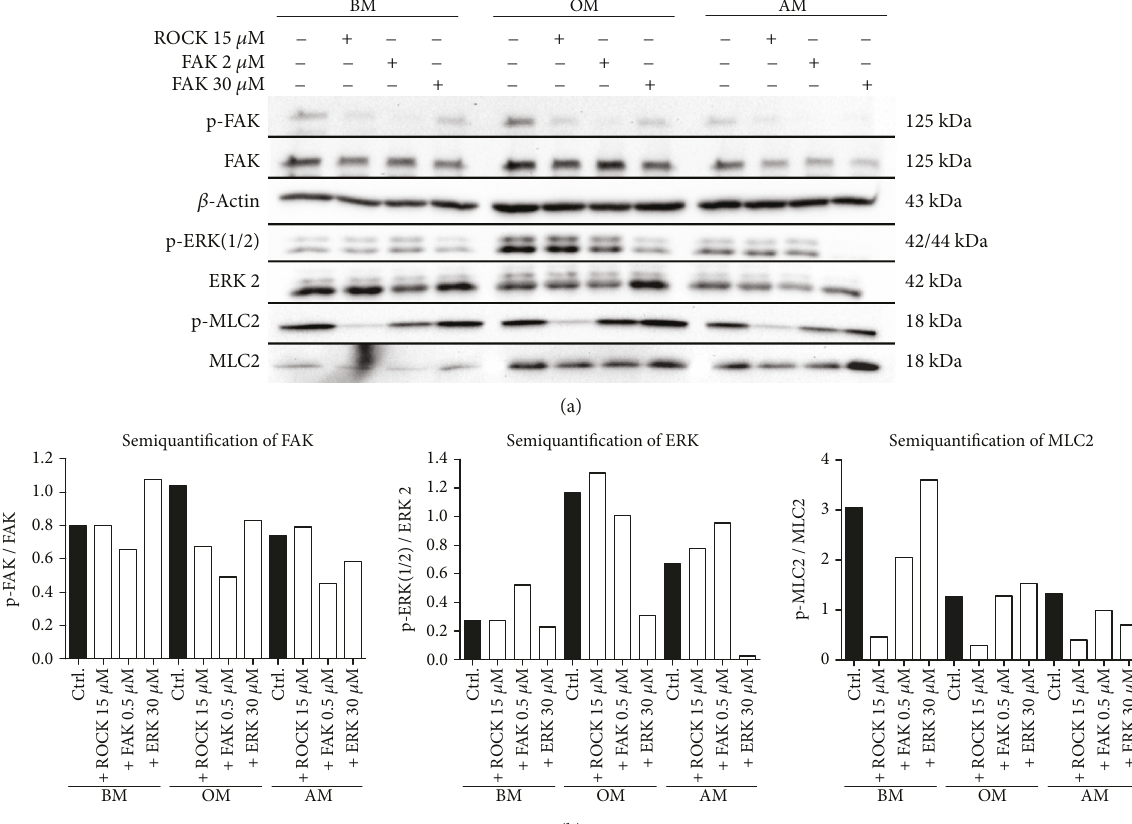
Figure 6: Intracellular protein activation at day 7 as a response to FAK, ROCK, and ERK inhibition. hASCs were cultured 7 days in BM, OM, and AM media containing 1% human serum supplemented with 15 μ M ROCK inhibitor, 2 μ M FAK inhibitor, or 30 μ M ERK inhibitor. (a) Representative WB results of immunoblotted p-FAK, FAK, β -actin, p-ERK(1/2), ERK 2, p-MLC2, and MLC2. (b) Semiquanti fi ed WB results representing the ratio of phosphorylated and basal form of FAK, ERK, and MLC2 proteins. BM: basic medium; OM: osteogenic medium; AM: adipogenic